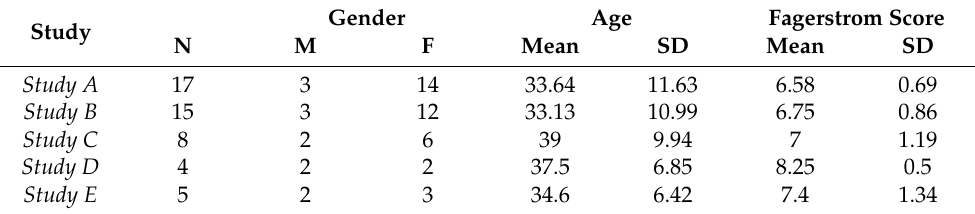
Table 1. Characterization of